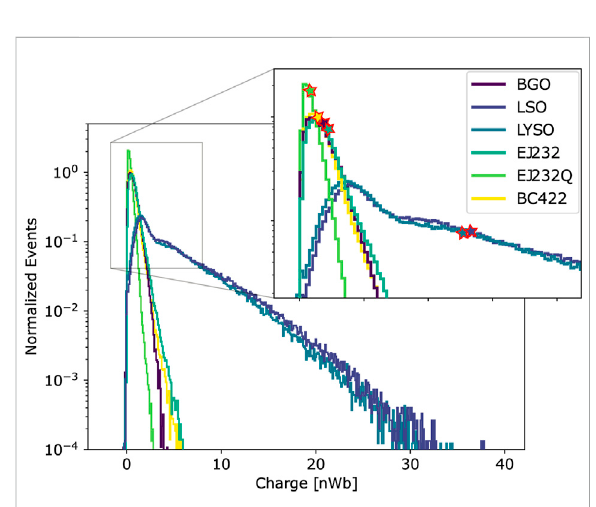
FIGURE 3 Integrated charge distribution of all the measured standard scintillators. The red outlined stars ( fi lled with the colors of the corresponding distribution) represent the mean collected